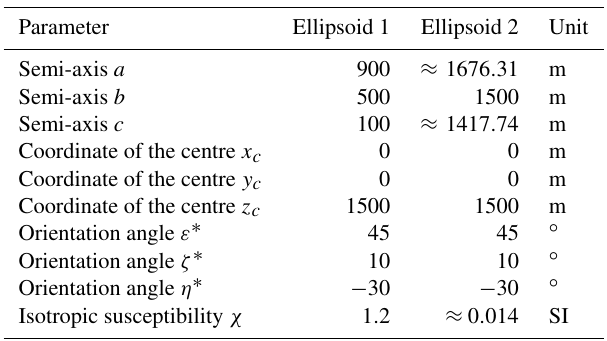
Table 1. Parameters defining two confocal ellipsoids.